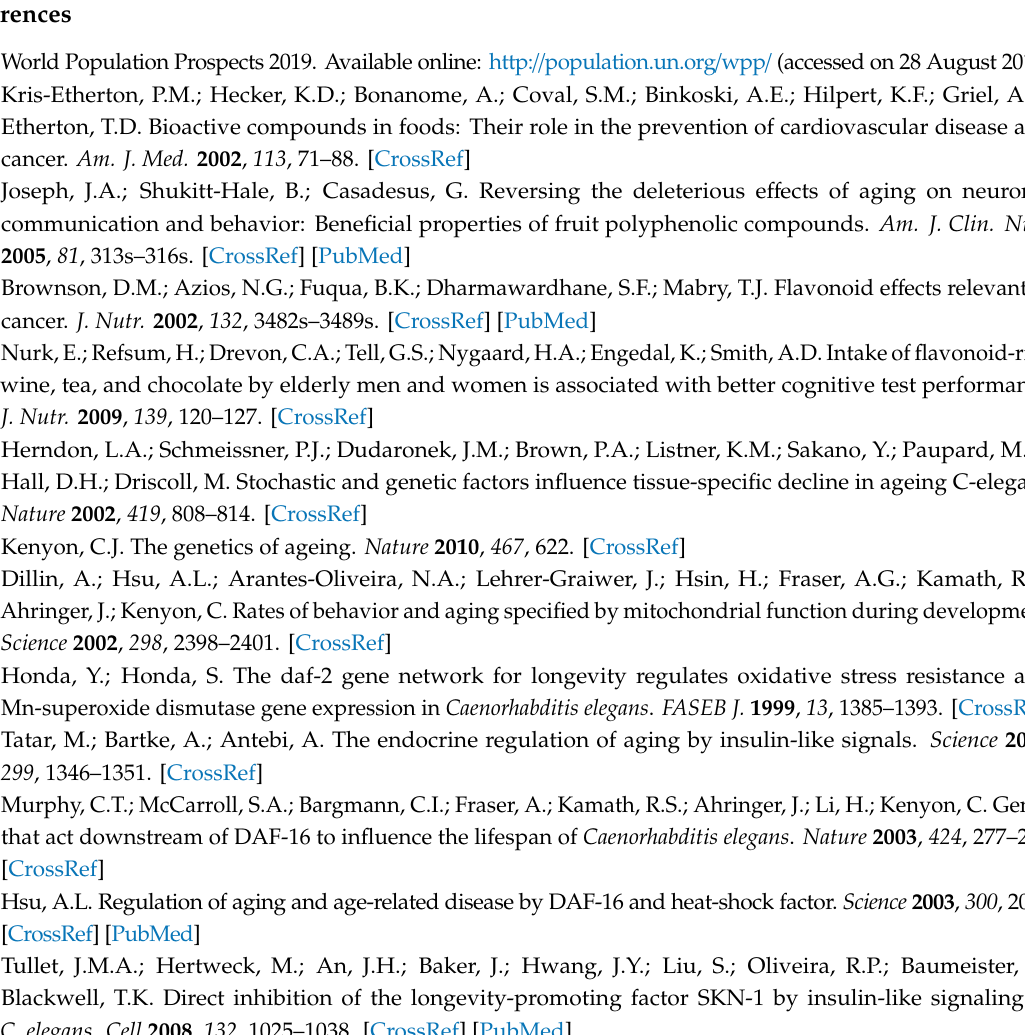
Table S1: Primers used for quantitative RT-PCR